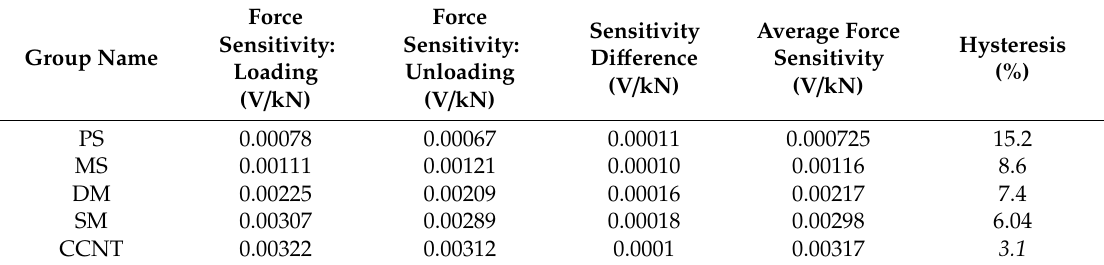
Table 3. Comparisons of force sensitivity and